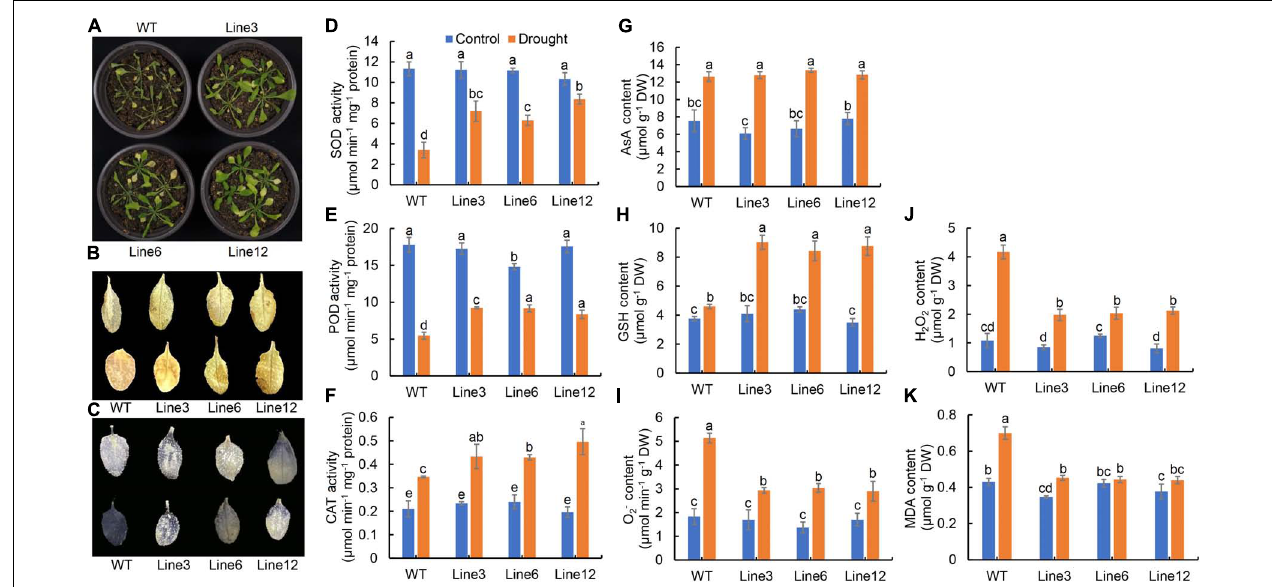
FIGURE 7 | Overexpression of HvbZIP21 in Arabidopsis . (A) Photo of WT and transgenic plants; (B) DAB staining of leaves of WT and transgenic plants; (C) NBT staining of leaves of WT and transgenic plants; (D) SOD activity; (E) POD activity; (F) CAT activity; (G) AsA content; (H) GSH content; (I) O 2 - content; (J) H 2 O 2 content; (K) MDA content. Different lowercase letters indicate significance levels at P ≤ 0.05 ( n = 3 independent replicates).